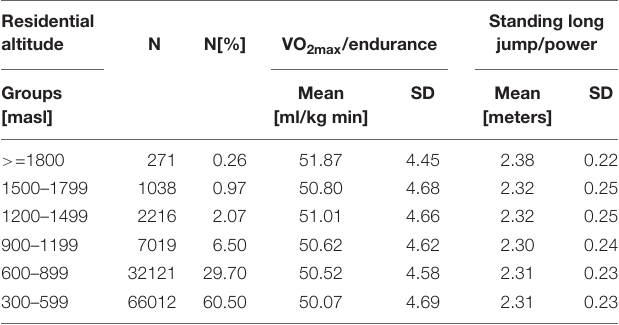
TABLE 1 | Descriptive statistics of endurance (VO 2max , [ml/kg min]) and muscle power performance (Standing Long Jump, [meters]) per residential altitude levels per 300 masl, based on the full dataset after multiple imputation.